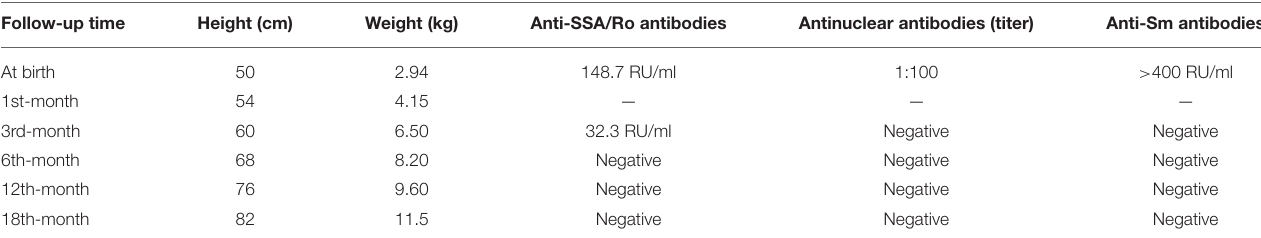
TABLE 2 | Follow-up of the baby after